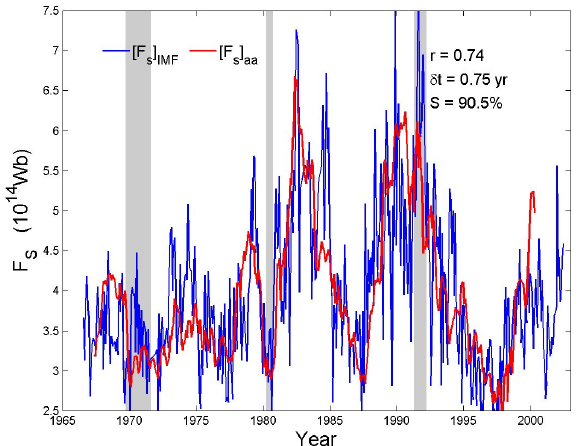
Fig. 1. Comparisons of the monthly open solar flux estimates de- rived from the radial component of the IMF and from the aa ge- omagnetic index ( [ Fs ] IMF and [ Fs ] aa , respectively, in blue and red). The grey bands mark the times of the reversal in the solar Figure 1. Comparisons of the monthly open solar flux estimates derived from the radial polar field by showing the times between the polar field reversals component of the IMF and from the aa geomagnetic index ([Fs] IMF and [Fs] aa , respectively, in in the two solar hemispheres. The correlation coefficient is r =0.74, blue and red). The grey bands mark the times of the reversal in the solar polar field by showing the times between the polar field reversals in the two solar hemispheres. The correlation which is significant at the S =90.5% level. The peak correlation is coefficient is r = 0.74, which is significant at the S = 90.5% level. The peak correlation is obtained at a lag δt =0.75yr (defined as positive with [ Fs ] IMF lead- obtained at a lag d t = 0.75 yr (defined as positive with [FS] IMF leading [FS] aa ) with an uncertainty ing [ FS ] aa ) with an uncertainty range 0.33–1.08yr. The [ Fs ] aa range 0.33-1.08yr. The [Fs] aa data sequence is plotted using the best-fit lag d t. data sequence is plotted using the best-fit lag δt